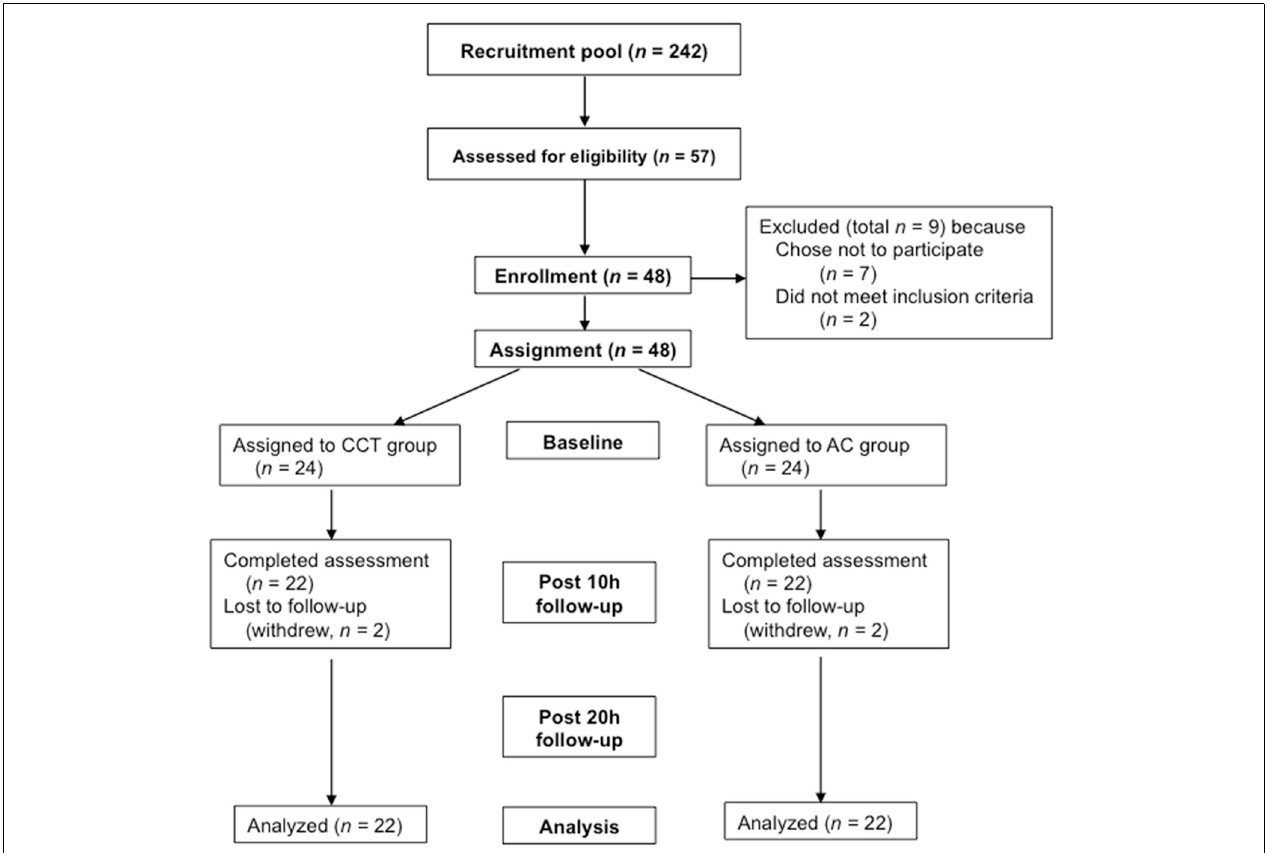
FIGURE 1 | Study design and participants